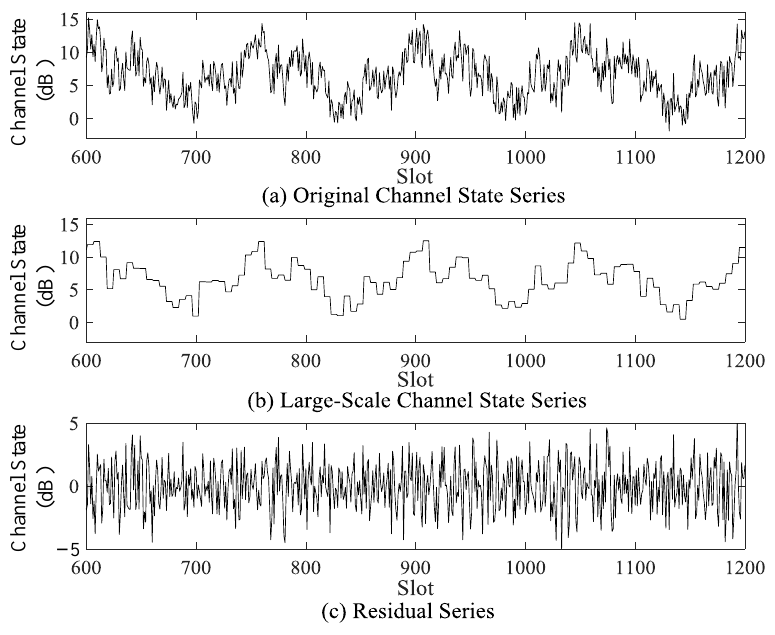
Figure 6. Channel state series